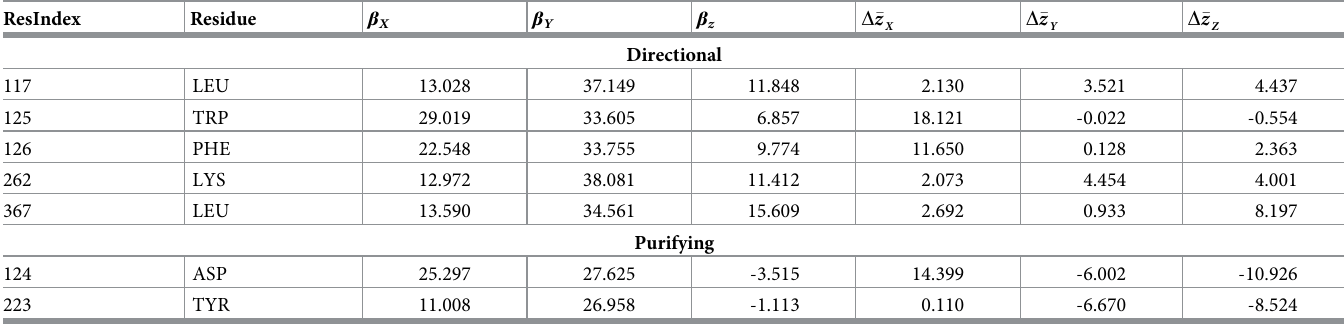
Table 3. Dynamics gradient in the top 5 residues. Top panel shows the residues where at least one of its coordinates is under positive gradient. Bottom panel contains the information of residues where at least one of its coordinates is under a negative gradient.